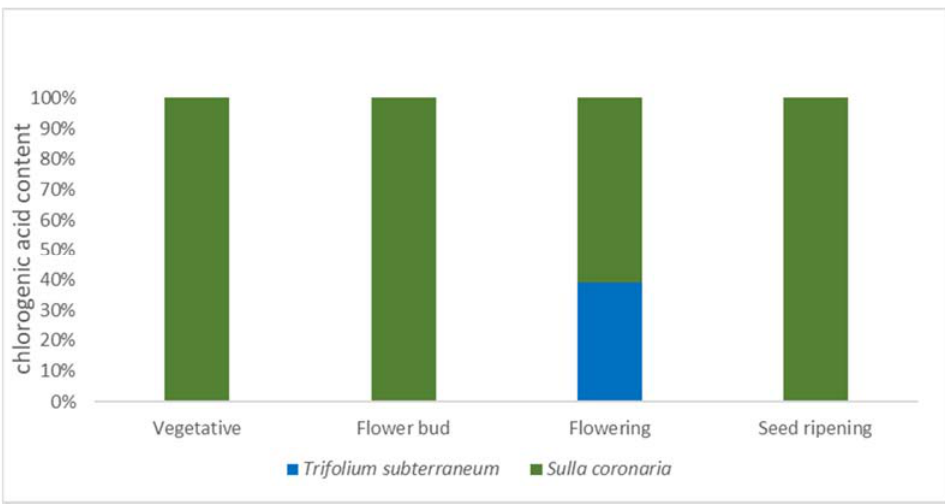
Figure 1. Cumulated content of chlorogenic acid from Trifolium subterraneum and Sulla coronaria shoots across phenological stages.